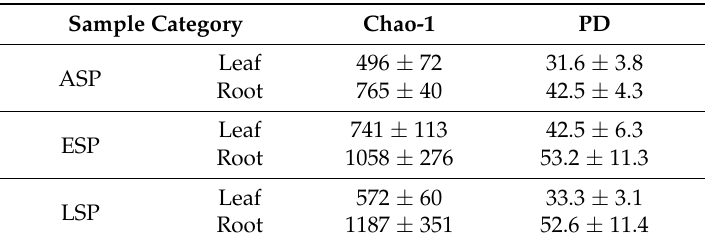
Table 2. Table reporting the values of Chao ‐ 1 and PD indexes, and their standard deviation, for the different categories of simples.